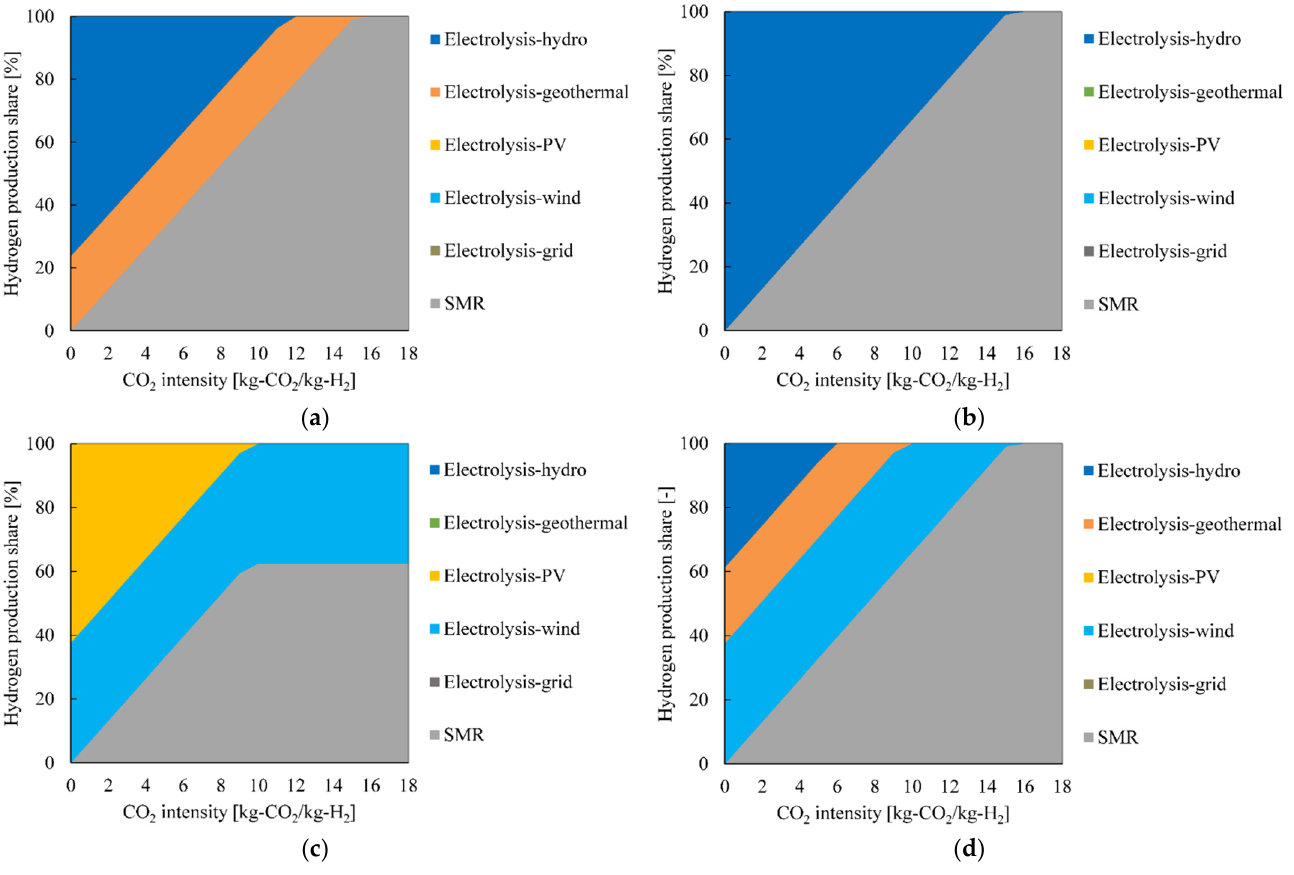
Figure 3. Share of hydrogen production routes in hydrogen production as function of the CO 2 intensity for hydrogen production on a cradle-to-gate. ( a ) Low-Cost scenario; ( b ) Low Energy Use scenario; ( c ) Water-Energy-Carbon scenario; ( d ) Water-Energy-Carbon-Cost scenario.